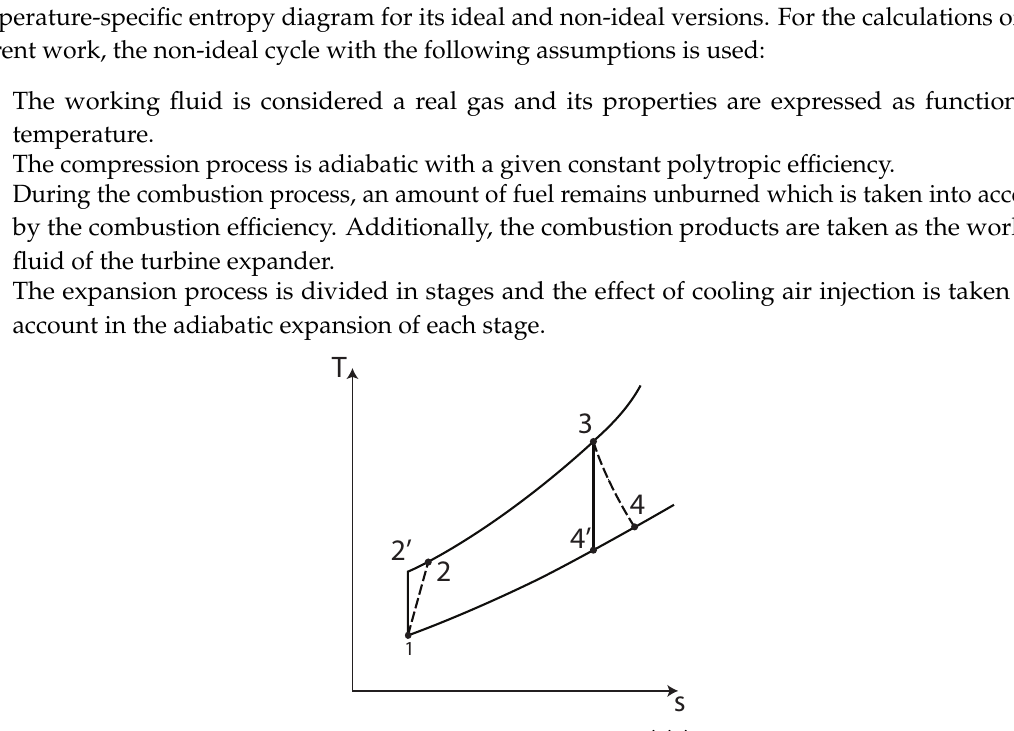
Figure 2. Temperature-specific entropy diagrams of the ideal prime 12 (cid:48) 3 (cid:48) 4 (cid:48) and real 1234 Joule–Brayton